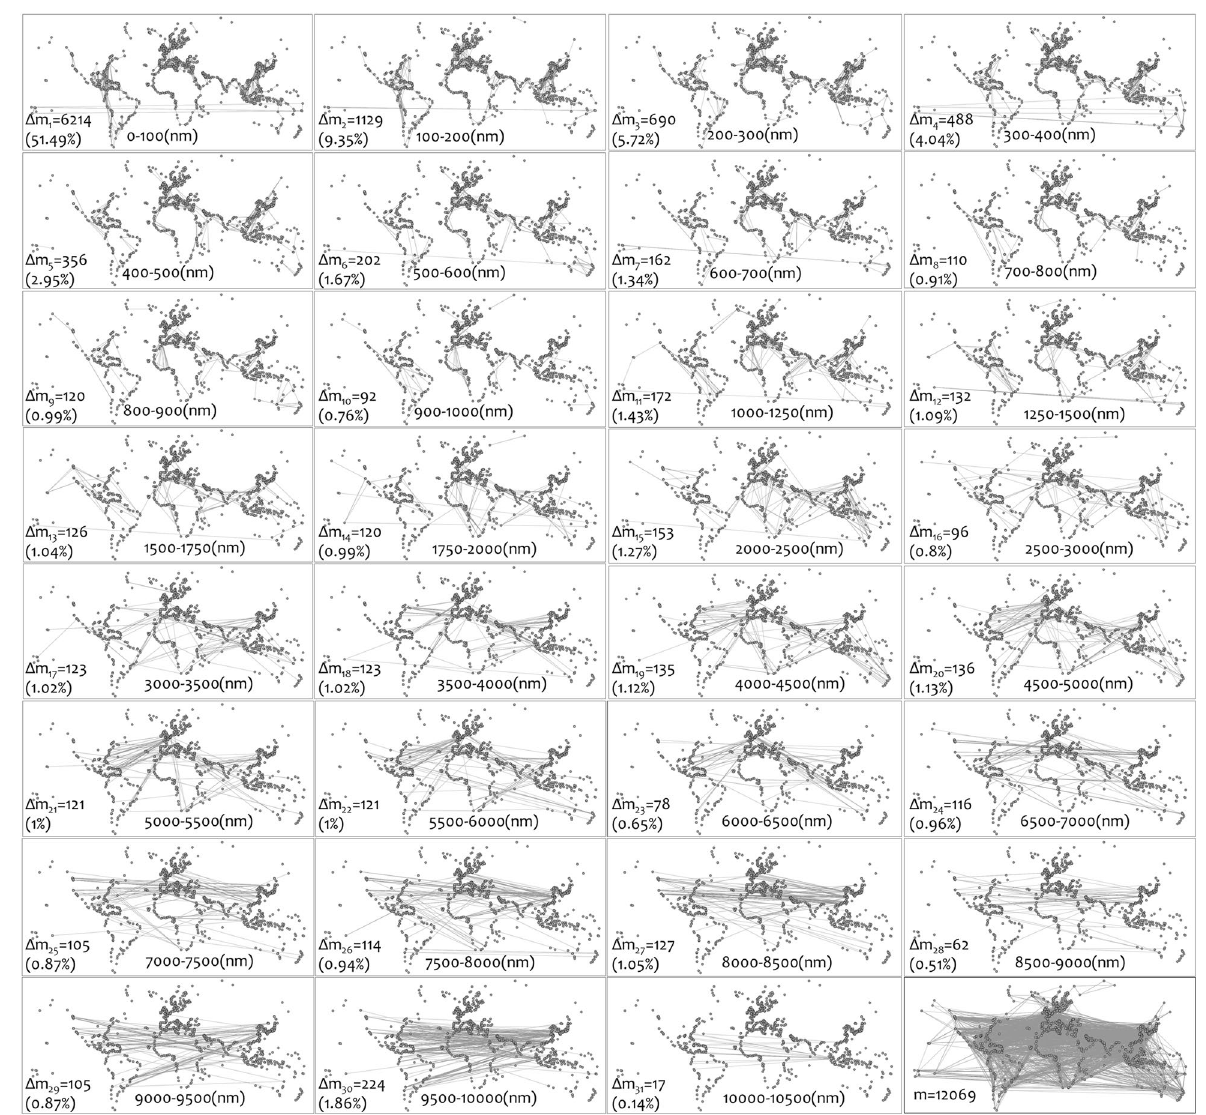
Figure 1. Edges (Δ m i ) added in each layer of the multilayer GCSN ( n = 1109 nodes, m = 12,069 edges). The edges m i included in layer G i are those with distance shorter than ( ≥) i nm, where: i = 100; 200; 300; 400; 500; 600; 700; 800; 900; 1000; 1250; 1500; 1750; 2000; 2500; 3000; 3500; 4000; 4500; 5000; 5500; 6000; 6500; 7000; 7500; 8000; 8500; 9000; 9500; 10,000; 10,500 (data from the year 2016); and are computed by the formula m i = m i– 1 + Δ m i ( m o =